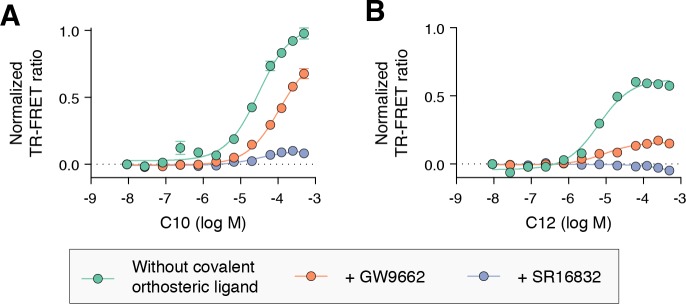
TR-FRET biochemical assays showing concentration-dependent changes in the recruitment of a peptide derived from the TRAP220 coactivator for (A) C10 and (B) C12.Experiments were performed in the absence or presence of a covalent orthosteric synthetic ligand as indicated. Data plotted as the average and S.E.M. of three experimental replicates.